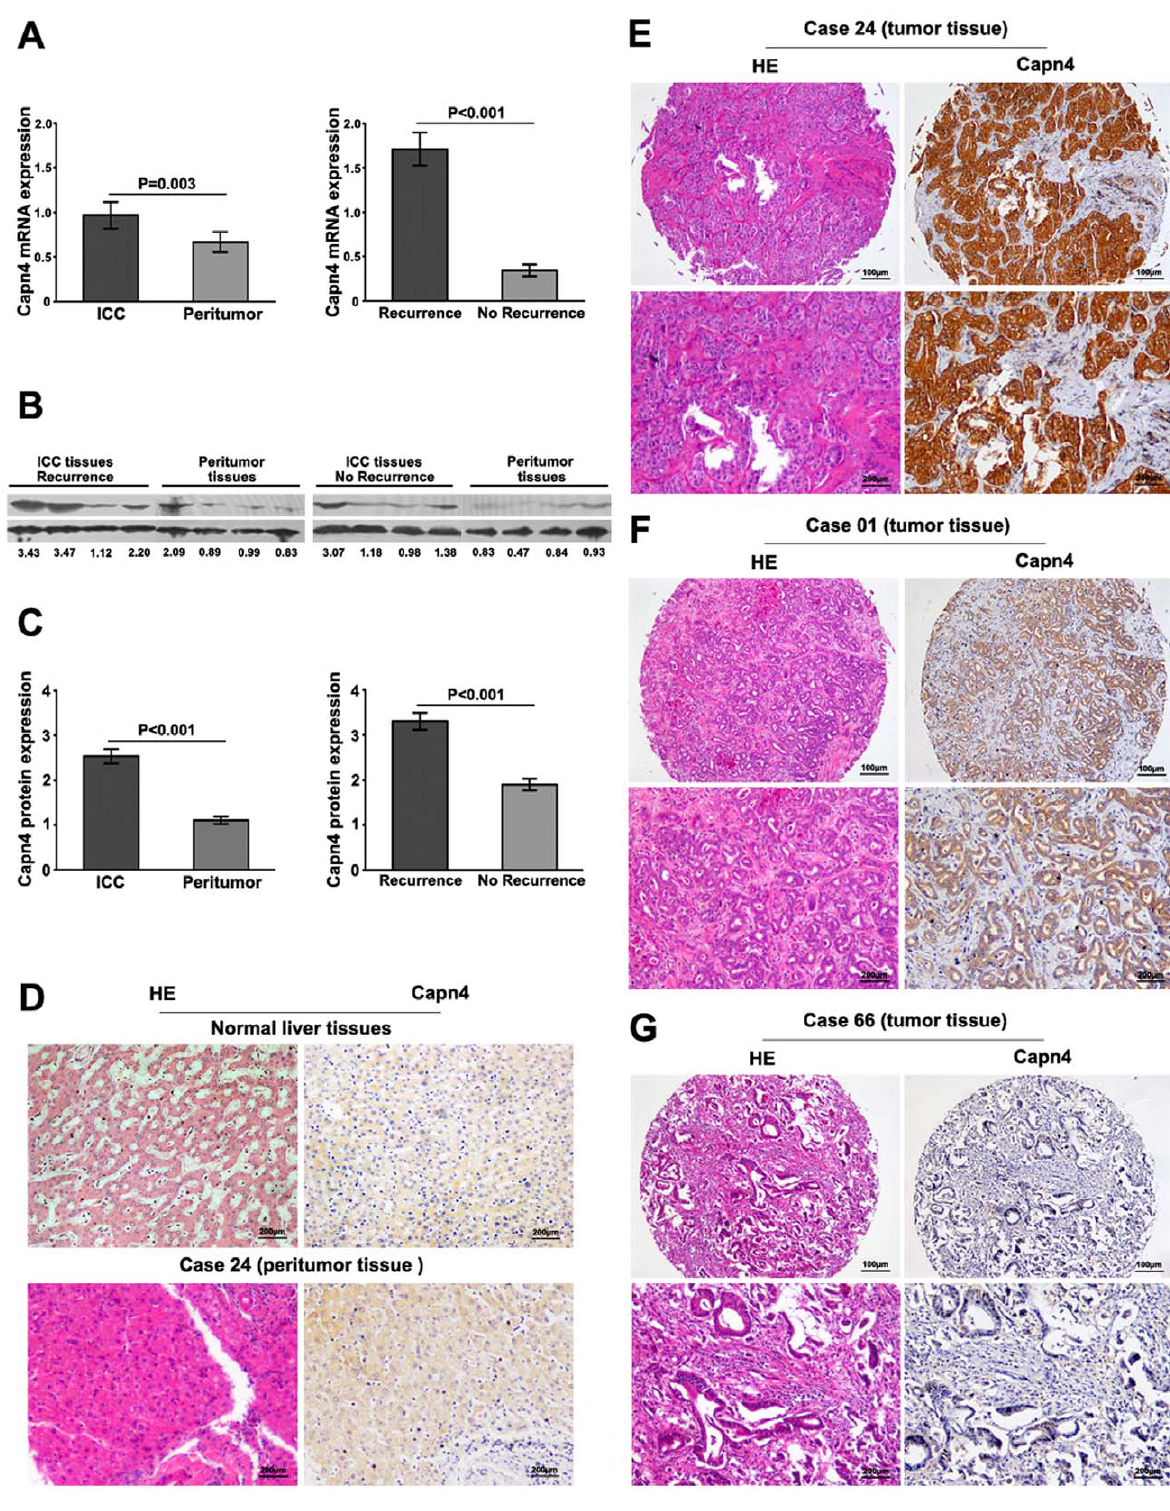
Figure 2. Capn4 expression in ICC and normal liver tissue. ( A ) Capn4 mRNA expression in ICC tumors was greater than peritumor tissues; Capn4 mRNA expression in patients with recurrent ICC tissues (15 of 33) was higher compared to the expression in those without recurrence (18 of 33). ( B, C ) Capn4 protein expression in ICC patients with no recurrence, those with recurrence, and peritumor tissues was detected by western blot analysis. ( D ) Hematoxylin-eosin (HE) and weak Capn4 staining are illustrated in normal liver and peritumor tissues. Capn4 protein expression had great variation in different tumor samples ( E, F, G ). Positive Capn4 was observed primarily in the cytoplasm. Representative Capn4 and HE staining are shown (strong, E ; moderate, F ; low, G ). Scale bar: 100 m m, 200 m m.